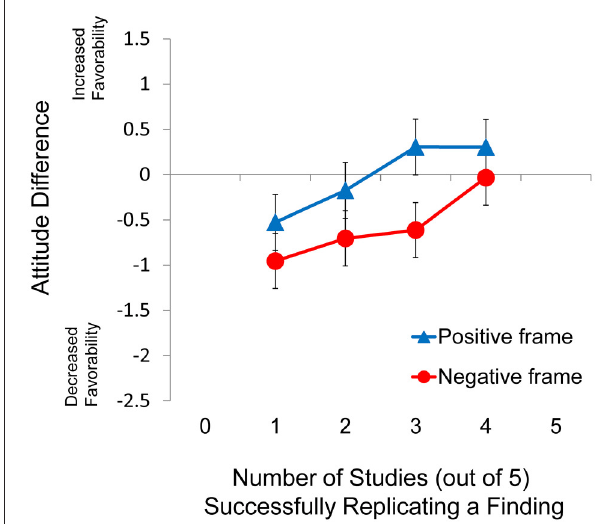
FIGURE 4 | Difference score as a function of frame for Experiment 4. Error bars indicate 95% confidence